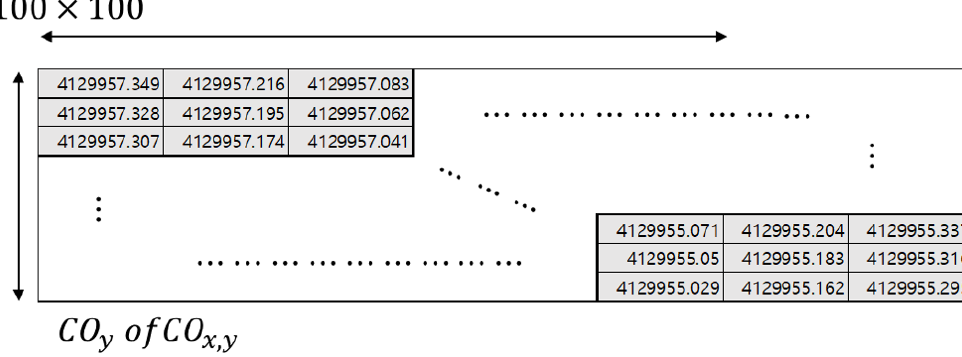
Figure 19. The 100 by 100 matrix about the y-axis value, which comes from the computation of CO x , y